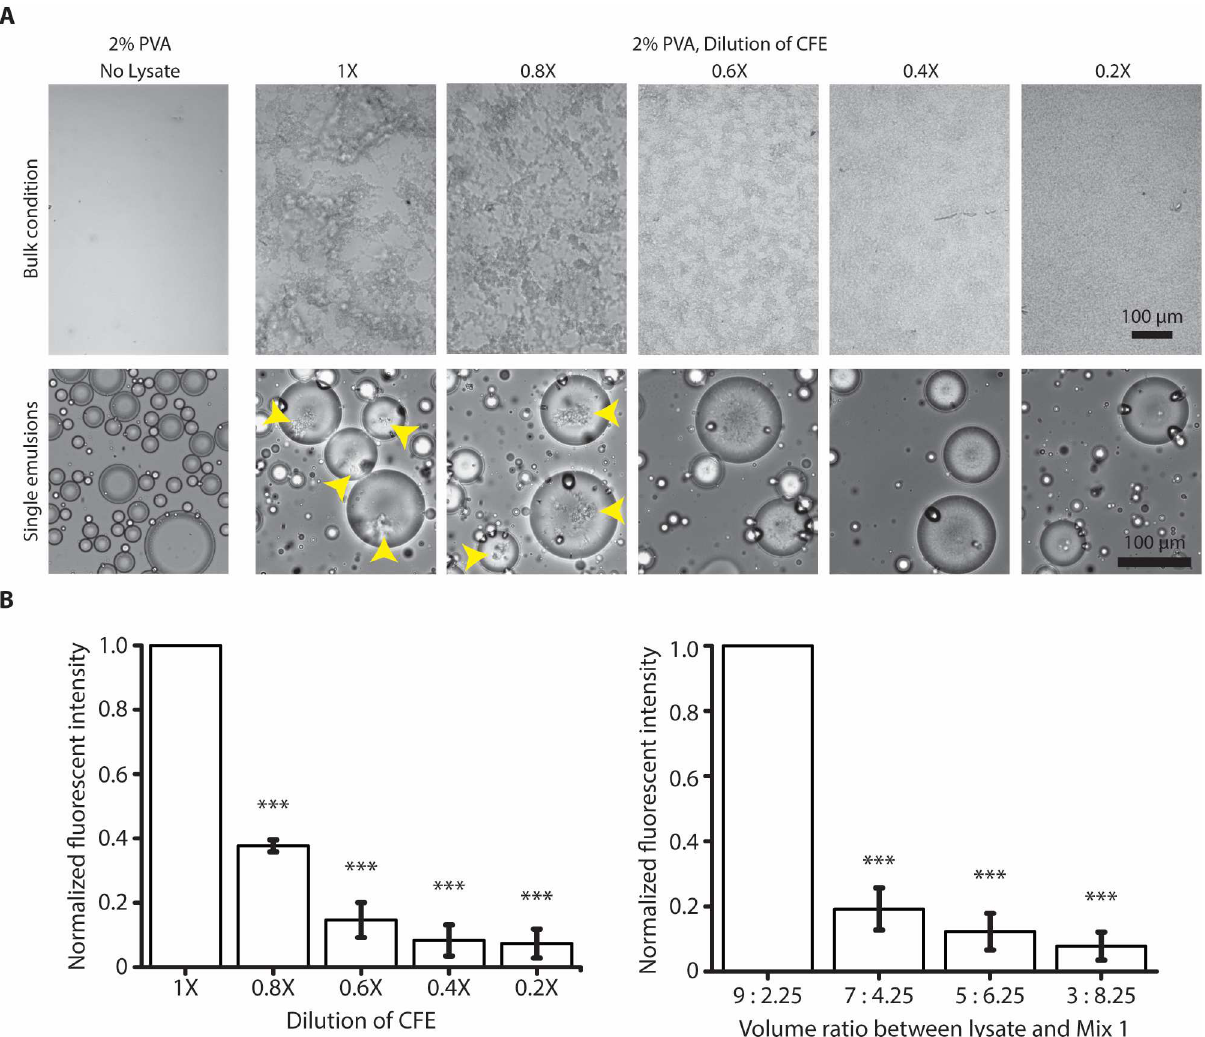
Fig 6. High concentration of mammalian Hela lysate is prone to aggregation when exposed to surfactant. (A) (Top) Representative brightfieldimages of different dilutionof CFE reactionwith 2% PVA under bulk condition.(Bottom) Representative brightfield images of single emulsionsencapsulating 2% PVA at different CFE dilutions. Yellow arrowheads denotethe appearanceof aggregates. (B) (Left) eGFP expressionin HeLa CFE as a function of CFE dilutionmeasuredin microwell plates (n = 4, ± S.E.), unpairedt test comparing with 1X; *** : p < 0.0001. (Right) eGFP expressionin HeLa CFE at different volume ratios betweenlysate and Mix 1 measuredin microwellplates (n = 4, ± S.E.), unpairedt test comparing with 9:2.25 volume ratio; *** : p < 0.0001.